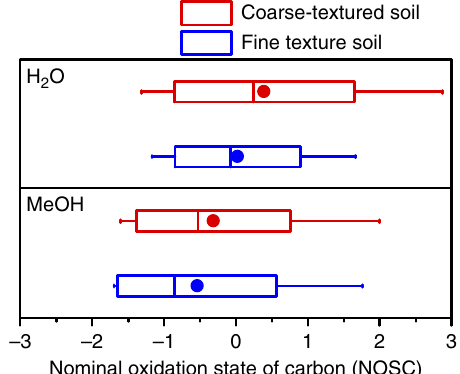
Fig. 6 Nominal oxidation state of carbon in fi ne- and coarse-textured upland soil varying in the abundance of anaerobic microsites. The boxes enclose the interquartile range, the whiskers indicate minimum and maximum values, horizontal bars dissecting the boxes represent the median values, and the symbols (dot) represent the mean. Carbon in fi ne-textured soil showed a lower oxidation state (i.e., it consisted of more reduced carbon compounds) than the coarse-textured soil when extracted with water (H 2 O) or methanol (MeOH). The average nominal oxidation state of carbon (NOSC) was calculated based on molecular formulae provided for water and methanol extracts analyzed by FT-ICR-MS. Details on the FT- ICR-MS analysis and NOSC calculations can be found in the “ Methods ”